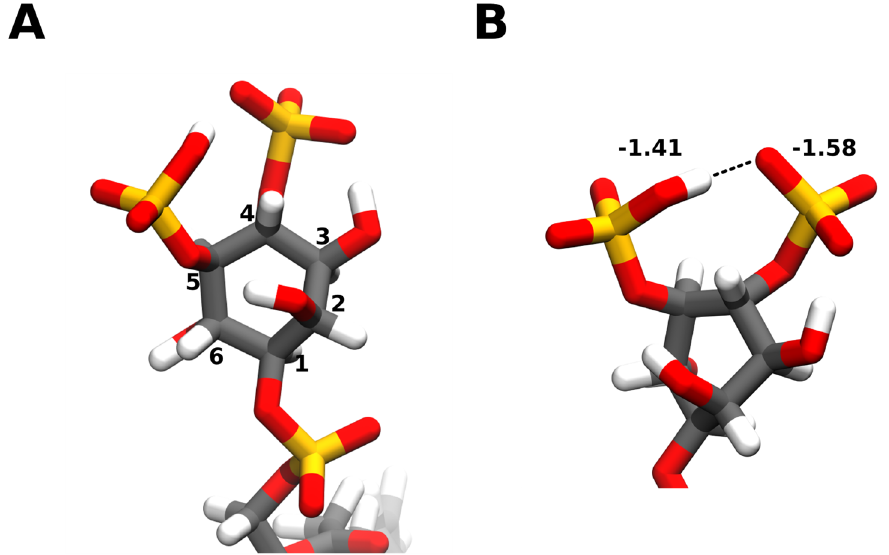
Figure 2. PI(4,5)P2 headgroup features. The PI(4,5)P 2 headgroup consists of myo -inositol ring where every hydroxyl substituent is at the equatorial position except for the hydroxyl in the position 2 of the ring, which is in an axial position. In the case of PIP2, the hydroxyls in positions 4 and 5 are enzymatically phosphorylated. It is linked to the diacylglycerol (DAG) backbone via a phosphodiester bond in position 1 ( A ). At pH 7.0, one of the phosphodiester proton dissociates, and the one remaining is shared between the two vicinal phosphomonoester groups. In terms of potential charge this means that, at pH 7.0, the charges would be − 1.58 and − 1.41 for the phosphomonoester groups at positions 4 and 5, respectively [19]. The lower charge of the 5-phosphomonoester group is attributed to a network of intramolecular hydrogen bonds that it is engaged in, which stabilize the proton ( B ). Carbon atoms are colored in grey, hydrogen in white, oxygen in red, and phosphorus in orange. Snapshots obtained from a simulation of a bilayer consisting of 95:5 mol ratio 1-palmitoyl-2-oleoyl- sn -glycero-3-phosphocholine (POPC): PI(4,5)P2, using the CHARMM36m forcefield run in GROMACS2019. Images were modeled using VMD.